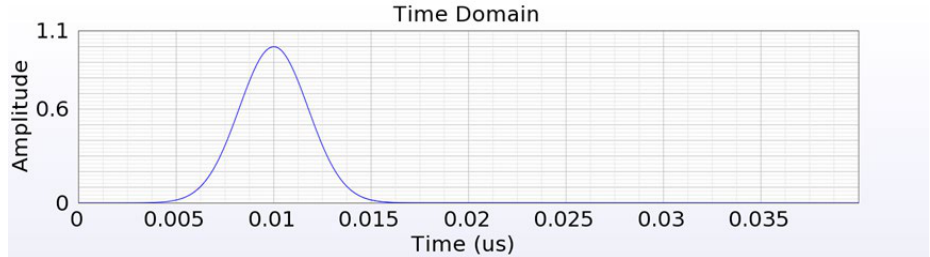
Figure 2. Time - domain waveform of Gaussian pulse current source .